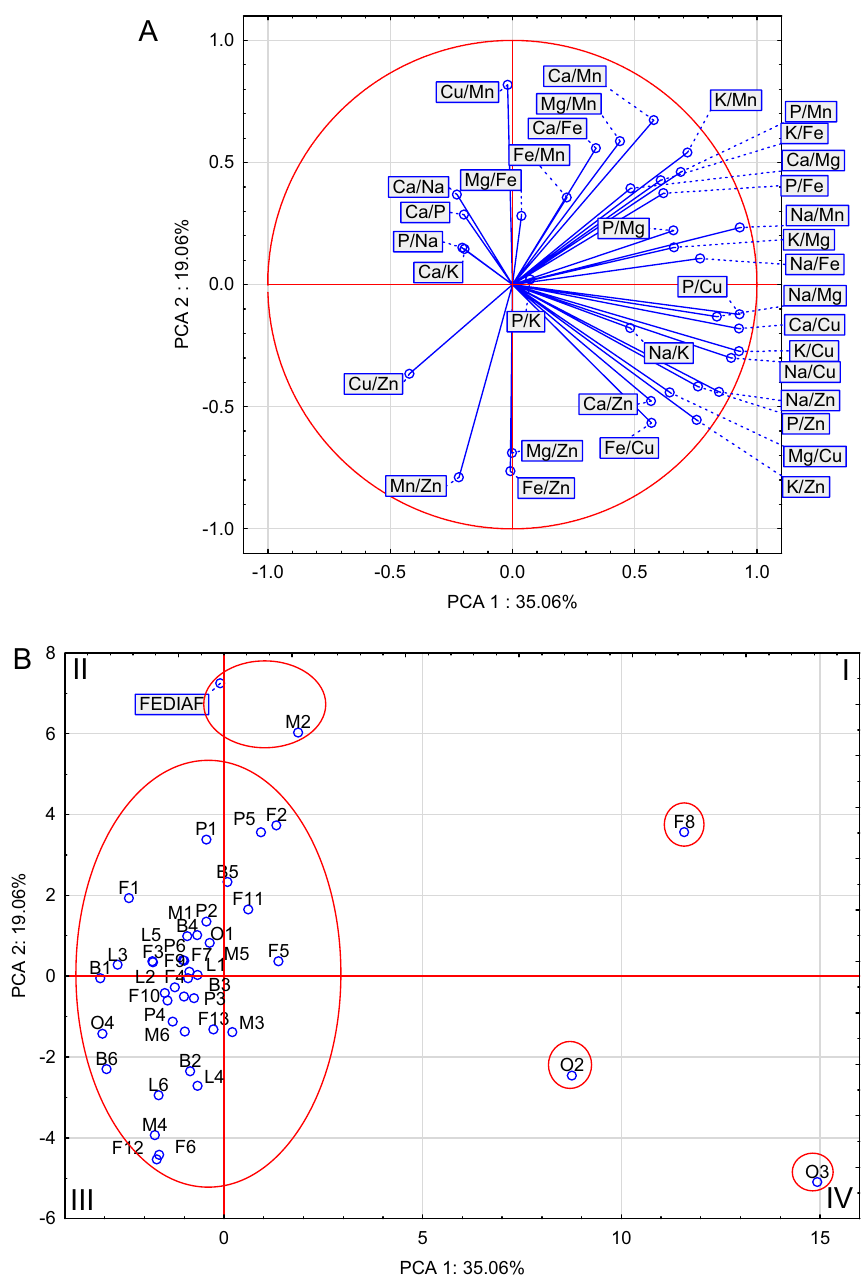
Figure 2. Biplot based on first two principal component axes for mineral ratios of analyzed dry dog foods ( A ) and distribution of 41 dry dog foods based on the first two components obtained from principal component analysis ( B